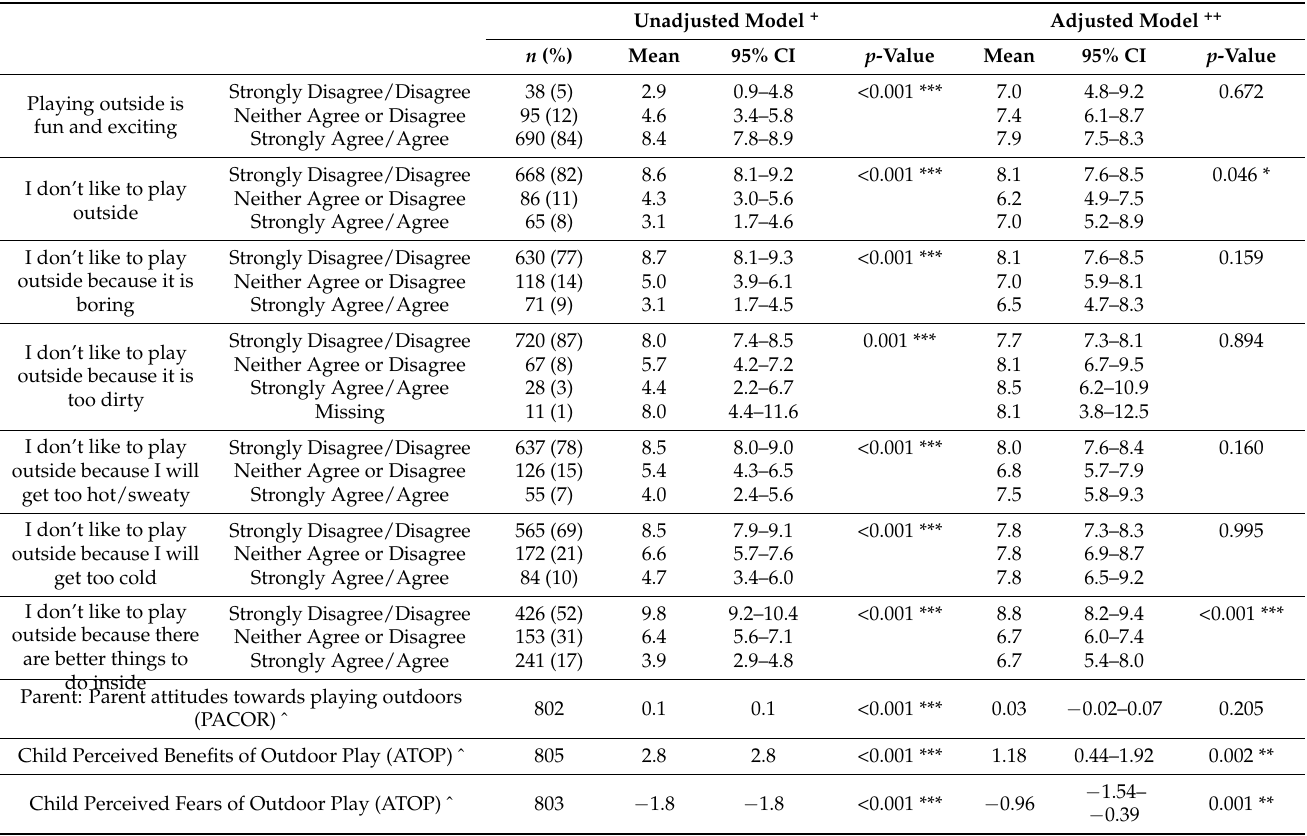
Table 7. Child and Parent Attitudes Towards Outdoor Play: Descriptives and Model 5 Results. Adjusted model controls for demographic variables in Set 1 (Table 3) 1